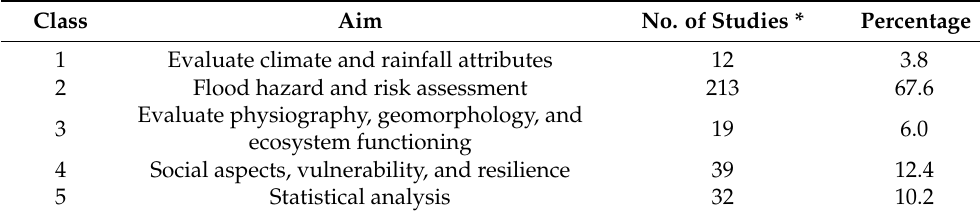
Table 5. Ranking of the surveyed articles based on the aim of the study.